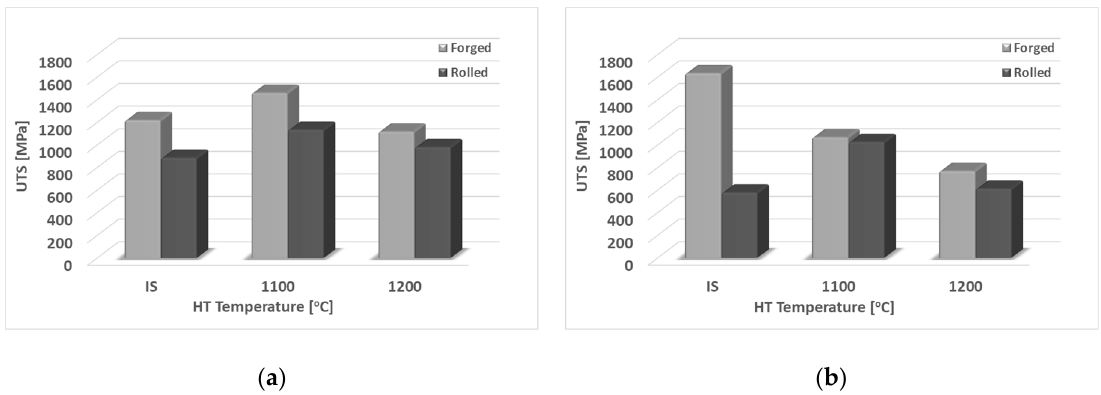
Figure 9. Ultimate tensile strengths (UTS) against the heat treatment (HT) for ( a ) OP1 and ( b ) OP2. With an increase in the HT temperature, both OP1 and OP2 show reductions in the improvement of UTS using the forging method. However, the rolled samples show a peak